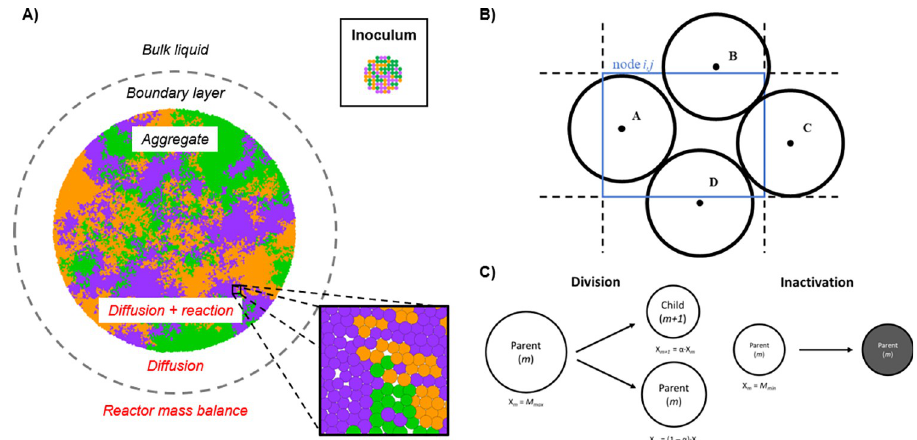
Fig 9. Individual-based Model description. (A) Representation of simulation domain. An expansion of specific aggregate zone (bottom-right square), and an example of the initial distribution of cells (top-right square) are shown, where microbes are represented as coloured circles with a specific radius: B1 –purple circle; B2 –green circle; B3 – orange circle. (B) Hypothetical position of microbes in the node. Only “microbe A” belongs to node i , j because its centre is inside the node. (C) Microbial division and inactivation. α is any stochastic value between 0.45–0.55. M max and M refer to the maximum and minimum mass that microbe can reach, min